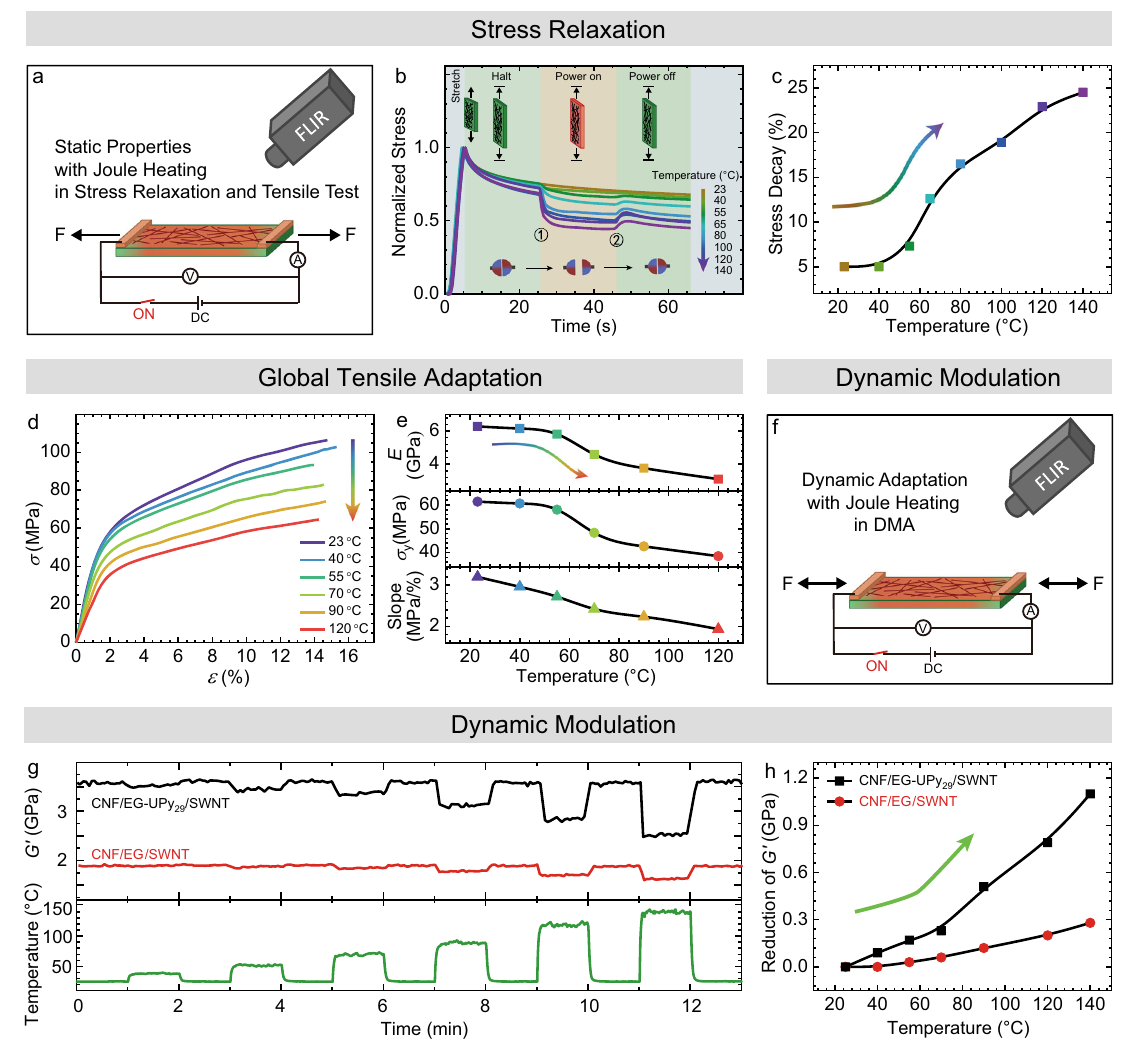
Fig. 3 Electricity-adaptive mechanical properties in CNF/polymer/SWNT (50/50/10) nanocomposites studied under Joule heating. a Illustration of the setup of electricity-adaptive properties testing in stress relaxation and tensile tests. The action area of the fi lm is 5.5 × 2 mm. b , c Electricity-adaptive stress relaxation. b Temporal evolution of the stress of CNF/EG-UPy 29 /SWNT (50/50/10) nanocomposites. This contains four steps: Stretching to strain = 1.0 ± 0.1%; relaxation for 20 s at ambient condition (power off); relaxation for 20 s with power on and voltage-controlled Joule heating; power off and further relaxation for 20 s. c Stress decay as a function of temperature with applied voltage from 25 to 45 s (indicated in ( a ) as from ① to ② ). The stress decay de fi ned as the relative reduction in stress during 20 s of power turn-on: ( σ 1 − σ 2 )/ σ 1 . d , e Electricity-adaptive global tensile properties. d Stress – strain curves of CNF/EG-UPy 29 /SWNT (50/50/10) nanocomposites under Joule heating and varying temperature. e From top to bottom, the panels show the corresponding E , σ y , and the slope of inelastic deformation region as a function of temperature. f – h Dynamic in situ modulation of the mechanical properties under Joule heating. f The illustration of the setup of electricity-adaptive properties testing inside a DMA using oscillatory deformation. g Temporal evolution of storage modulus, G ′ , tested using DMA with varied voltage to control the temperature, which shows the reversible and electricity-adaptive properties of the bioinspired nanocomposites. The black and red lines are the G ′ for CNF/EG-UPy 29 /SWNT (50/50/10) and CNF/EG/SWNT (50/50/10), and the green line the corresponds to the temperature during the tests. h The reduction of G ′ as a function of temperature extracted from ( d